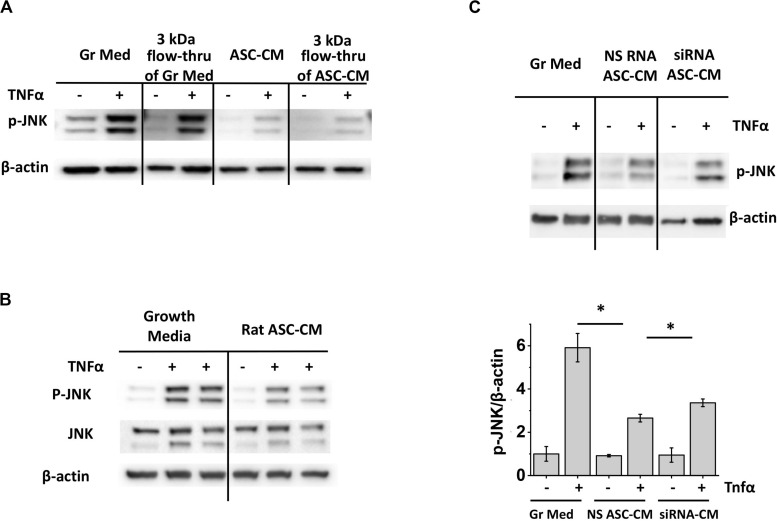
Inhibition of JNK activation is mediated by small MW factors in ASC-CM which are not species-specific. Depletion of heme oxygenase 1 in ASC attenuates ASC-CM ability to inhibit JNK activation. (A) HPAEC pretreated with the original growth media and ASC-CM or the 3 kDa flow-through fractions of growth media and ASC-CM were challenged with 2 ng/ml TNFα for 4 h. (B) HPAEC pretreated with growth media or rat ASC-CM were challenged with 2 ng/ml TNFα for 4 h. (C) HPAEC pretreated with growth media or ASC-CM generated by non-specific RNA-treated ASC (NS RNA ASC-CM) or heme oxygenase 1 siRNA-treated ASC (siRNA ASC-CM) were challenged with 2 ng/ml TNFα for 4 h. Cell lysates were analyzed with antibodies to p-JNK and β-actin (loading control). Data from three independent experiments were pooled and presented as cleaved caspase 3/β-actin ratio mean ± SEM. ∗Significance between TNF-stimulated groups assessed by t-test with Welch’s correction as indicated (p < 0.05).